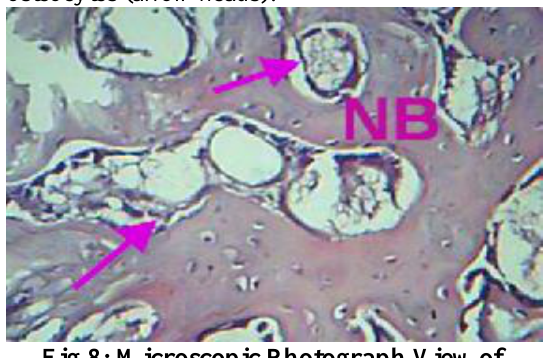
Fig 8: Microscopic Photograph View of Al O and AgNO3 Coated Ti Implant after 4 2 3 Weeks of Implantation. Hand E×10